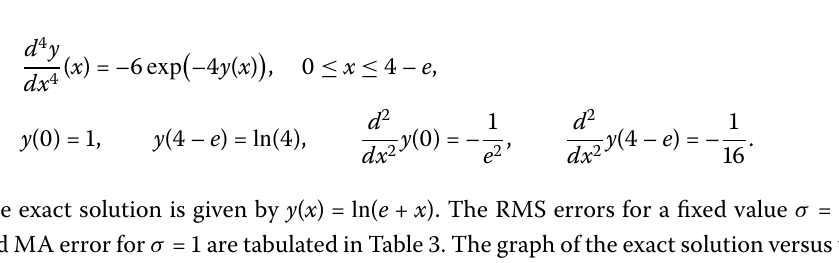
Figure 2 Graph of the exact solution y ( x ) = ( x 2 – 1)sin( x ) versus the approximate solution in fourth-order uniform mesh method for N = 32 and σ = 1 for Example